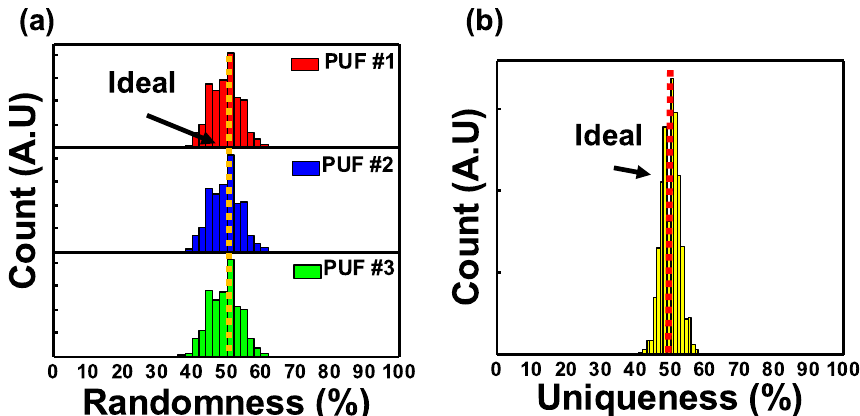
Figure 4. Randomness and uniqueness of the M13-SWNT based PUFs. ( a ) The randomness of each M13- SWNT based PUFs fabricated in the same batch is close to the ideal value of 50%. ( b ) The uniqueness of M13- SWNT based PUFs close to the ideal value of 50%.